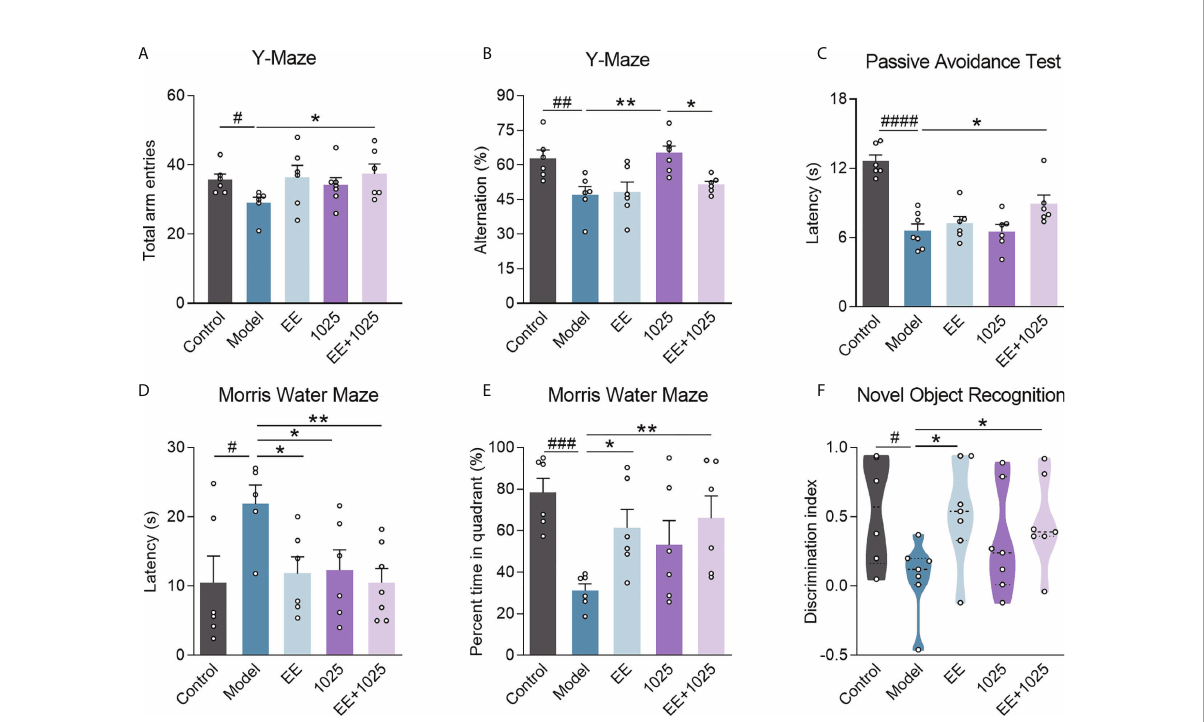
FIGURE 2 EE combined with B . breve CCFM1025 treatment alleviates AD-induced cognitive and behavioral de fi cits. Total arm entries (A) and spontaneous alternation behavior (B) in Y-maze test (n = 6-8). (C) Escape latency of passive avoidance test (n = 6-8). The escape latency (D) and percent time in target quadrant (E) during the probe phase (day 6) of the Morris water maze. (F) Discrimination index in the novel object recognition task (n = 6-8). Black horizontal dashed lines in violin plots depict medians, the bottom and top lines represent, respectively, the 25th and 75th percentile. Data are presented as mean ± standard error of the mean (mean ± SEM). Each data point represents one independent mouse. Control vs. Model: # P < 0.05, ## P < 0.01, ### P < 0.001, #### P < 0.0001 by unpaired student ’ s t-test; * P < 0.05, ** P < 0.01 as determined by one-way